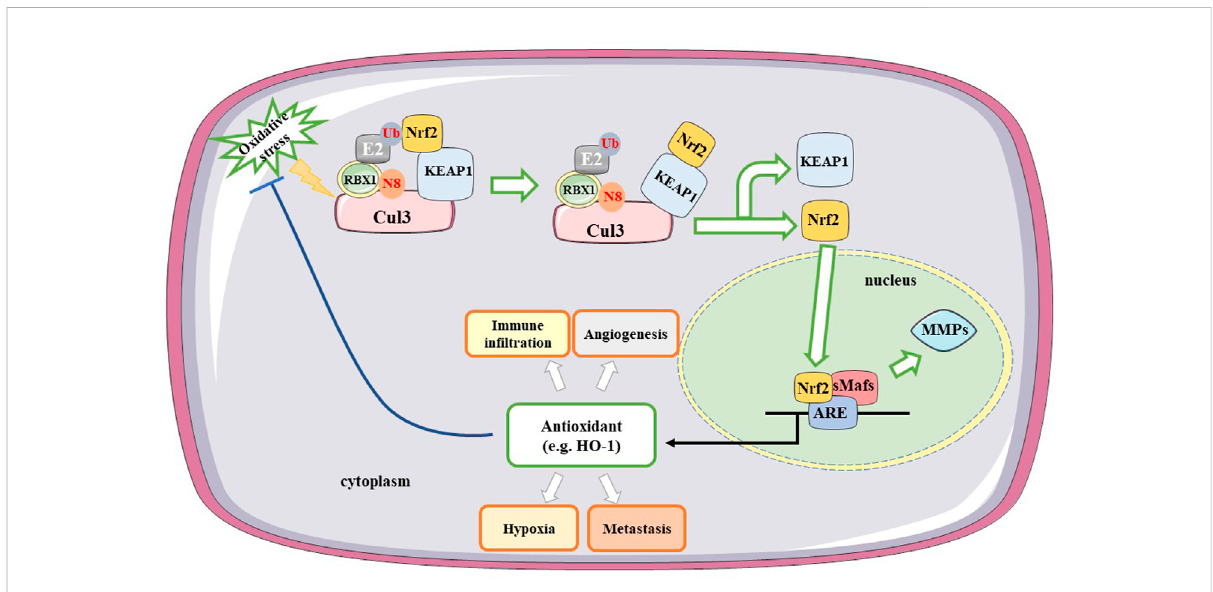
FIGURE 2 Mechanisms of Nrf2 in treating gliomas. A complex consisting of Cul3, KEAP1, and RBX1 binds to E2 ubiquitin-conjugating enzyme. Under the oxidative stress, Nrf2 induces a conformational change and dissociates from KEAP1, translocating to the nucleus. Nrf2 binds with ARE and heterodimerizes with sMafs. Downregulating Nrf2 expression inactivates MMP-9 and reduces the migration and invasion of gliomas. HO-1 as a downstream factor of Nrf2 participates in immune in fi ltration, hypoxia, metastasis and angiogenesis. Cul3, Cullin 3; Nrf2, nuclear factor erythroid 2-related factor 2; KEAP1, Kelch-like ECH-associated protein 1; RBX1, ring-box-1; ARE, antioxidant response elements; MMPs, matrix metalloproteinases; H O -1, heme oxygenase 1; sMafs, small musculoaponeurotic fi brosarcoma proteins; N8, Nedd8; Ub,